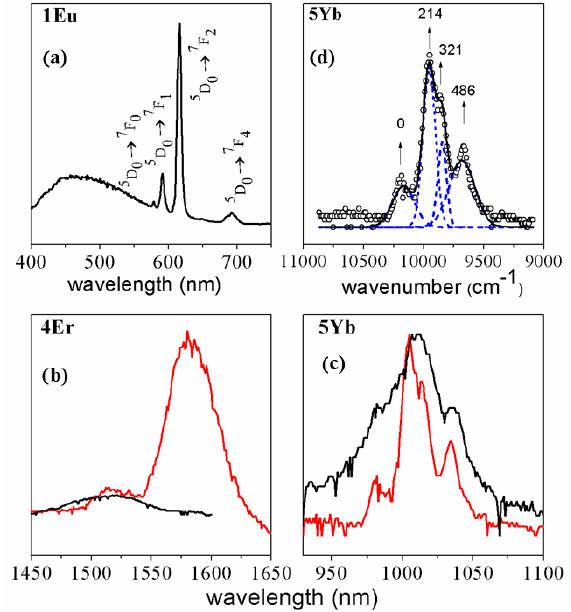
Figure 7. ( a ) Emission spectra at r.t. at λ ex = 350 nm in solid state of 1Eu ; ( b , c ) Emission spectra of 4Er and 5Yb at r.t (black spectra) and 77 K (red spectra) at λ ex = 360 nm; ( d ) Gaussian deconvolution of the emission spectrum of 5Yb , circles: Experimental spectrum, dashed lines: Gaussian deconvolutions, bold line: summed spectrum. Energy of the Stark sublevels.